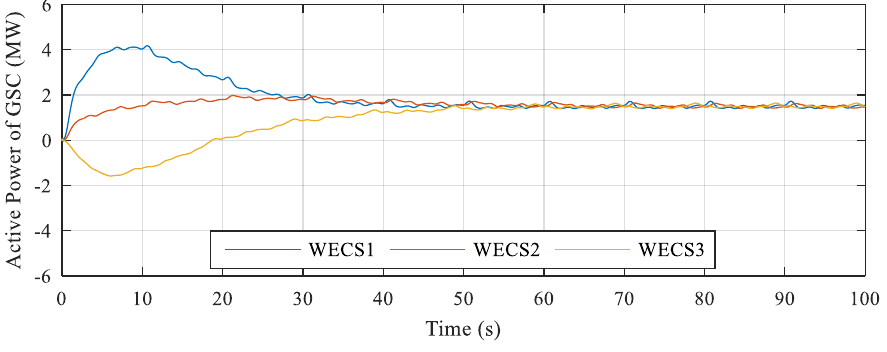
Figure 10. Active power of GSC with the proposed controller (Case 1).